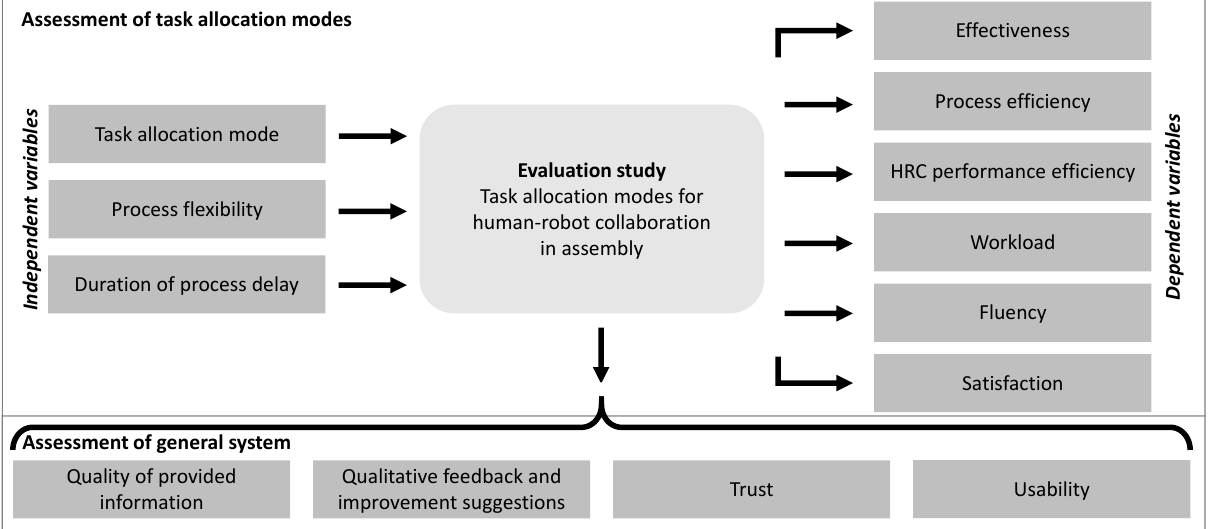
Figure 15. Dependent and independent variables of the evaluation study.